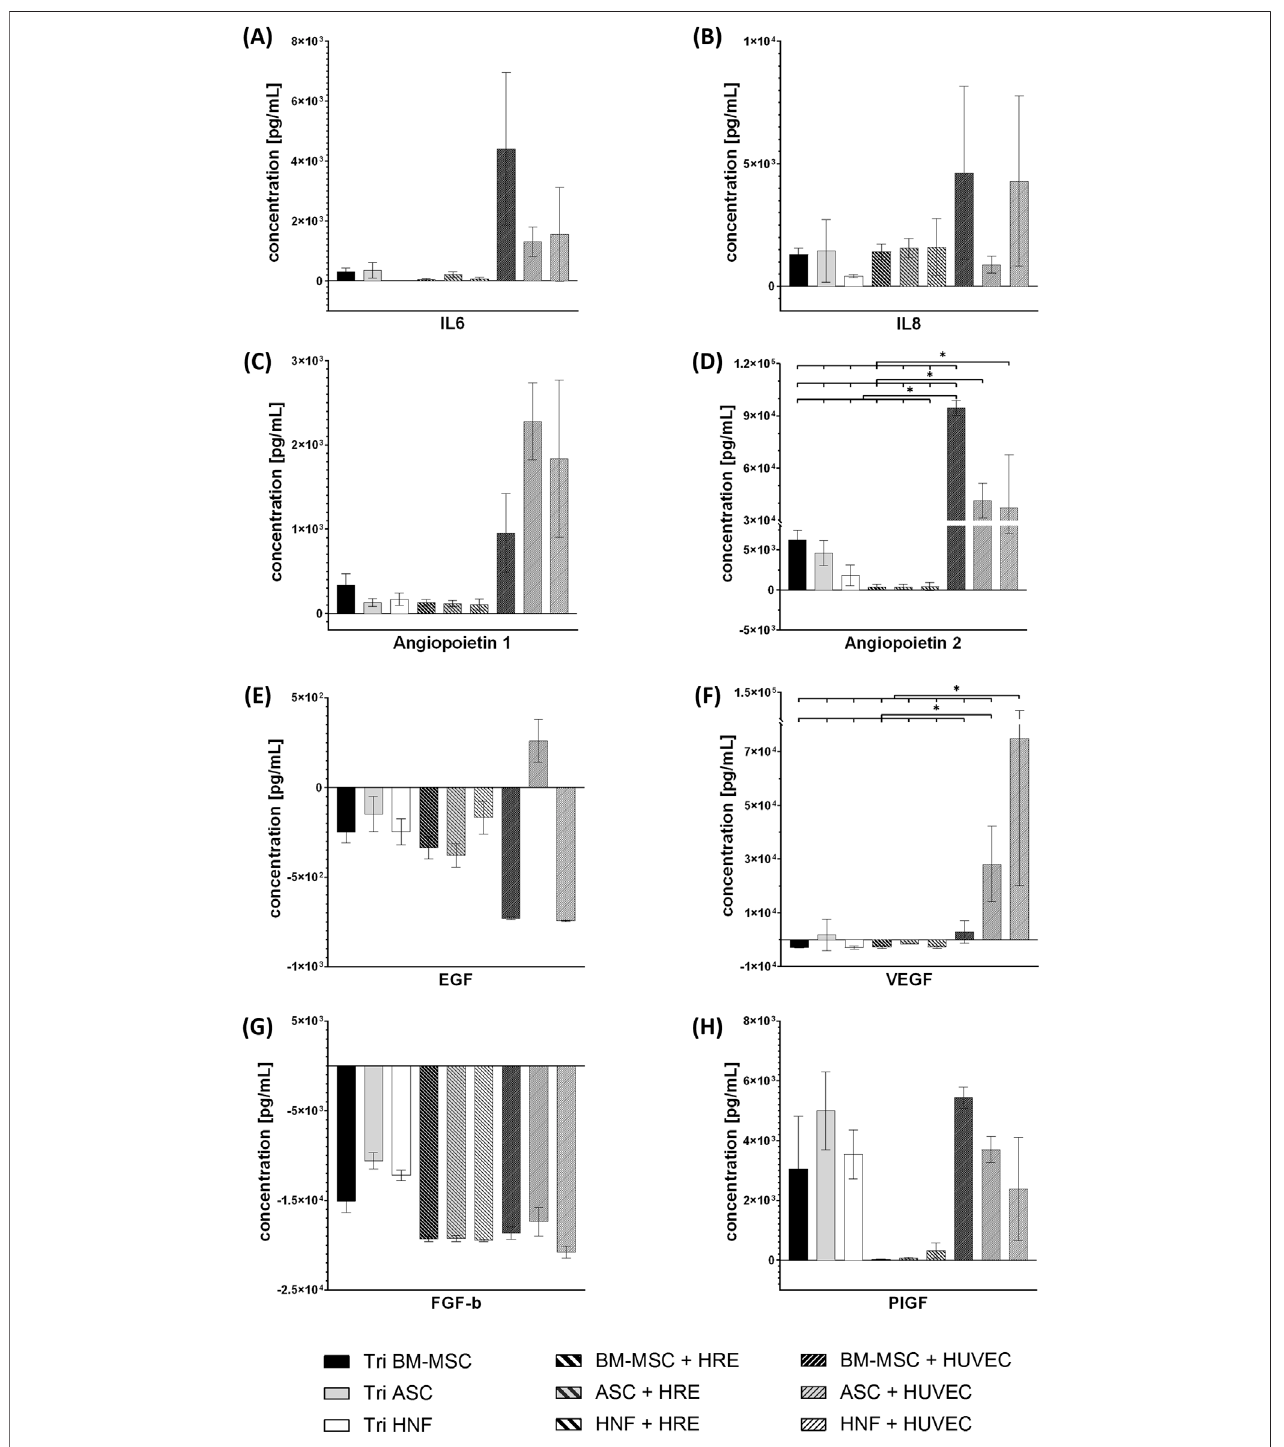
FIGURE 8 | LEGENDPlex immunoassay for cytokines associated with angiogenesis and in fl ammation. Concentrations of cytokines IL6 (A) , IL8 (B) , angiopoietin 1 (C) ,angiopoietin2 (D) ,EGF (E) ,VEGF (F) ,FGF-b (G) andPIGF (H) intri-cultures,co-cultureswithHREandco-cultureswithHUVECusingdifferentsupportingcelltypes. Concentrations have been normalized to cell-free medium. Error bars show standard deviation. Statistical signi fi cance indicated by “ * ” shows signi fi cance ( p < 0.05) between mean values.